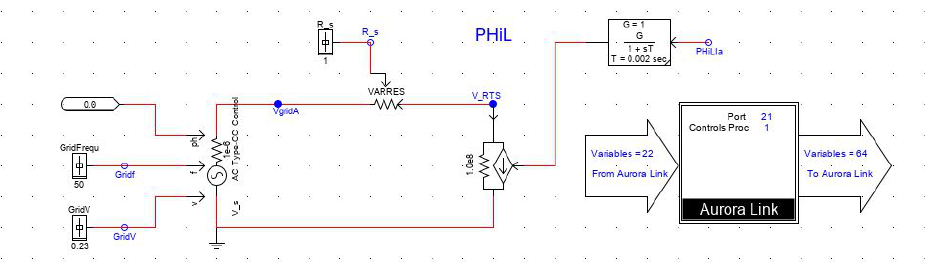
Figure 15. Virtual part of the PHiL simulation modeled in RSCAD.